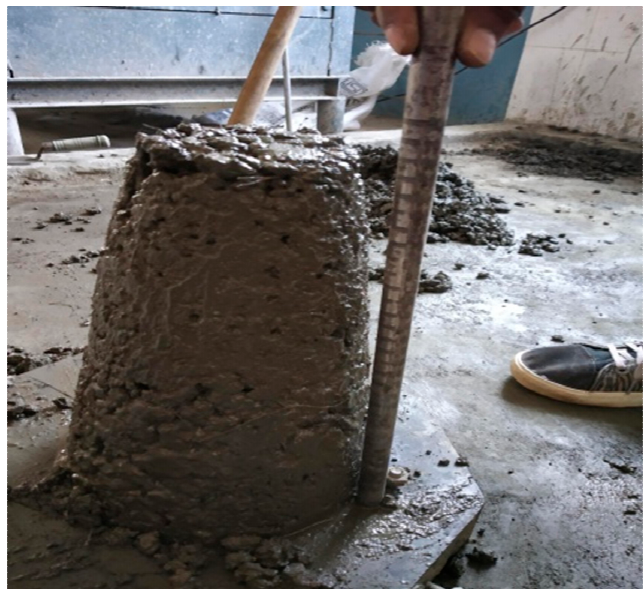
Figure 1. Slump of CS concrete.